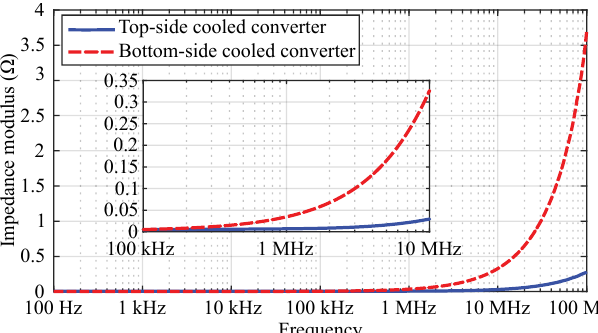
Figure 15. PCB impedances obtained from an electromagnetic simulation.